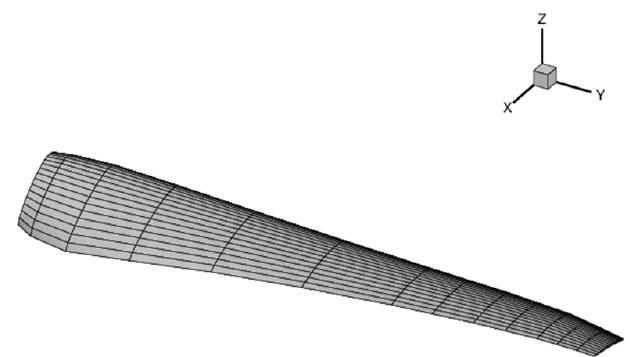
Figure 5. Motorization 2.